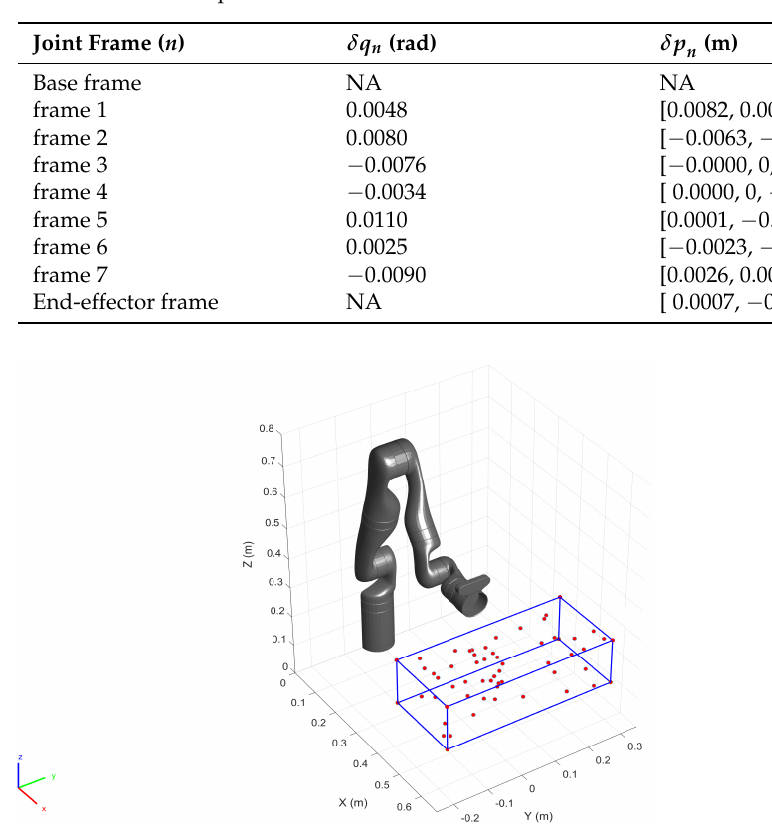
Table 8. Calibration parameters for Model 2.